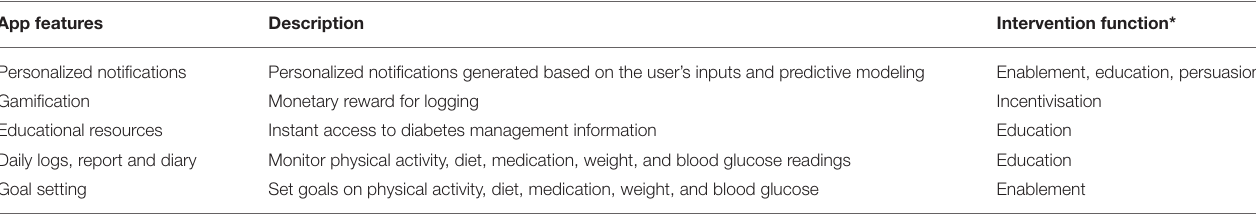
TABLE 1 | EMPOWER app features.